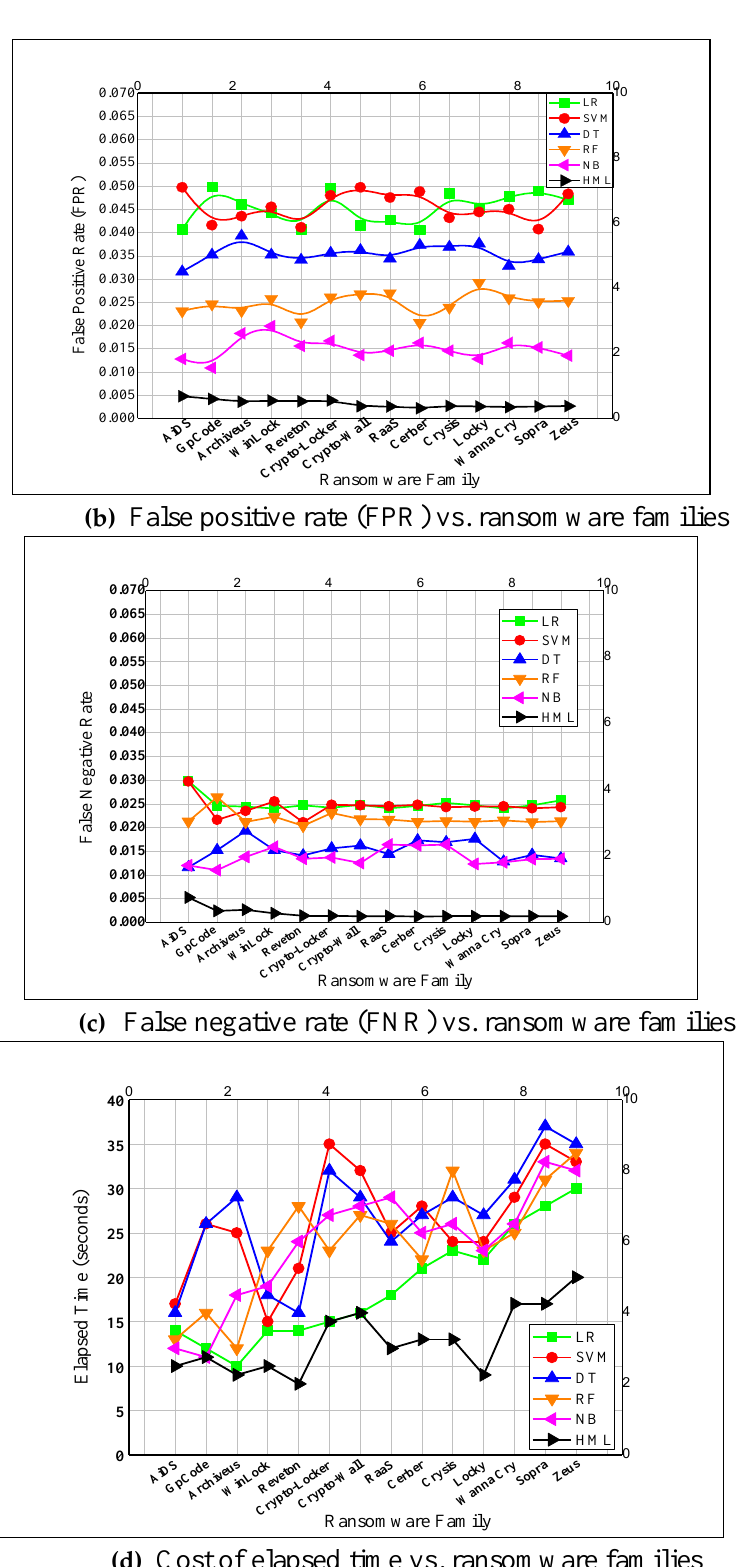
Figure 6. Evaluation of the proposed machine learner against state-of-the-art machine learners.